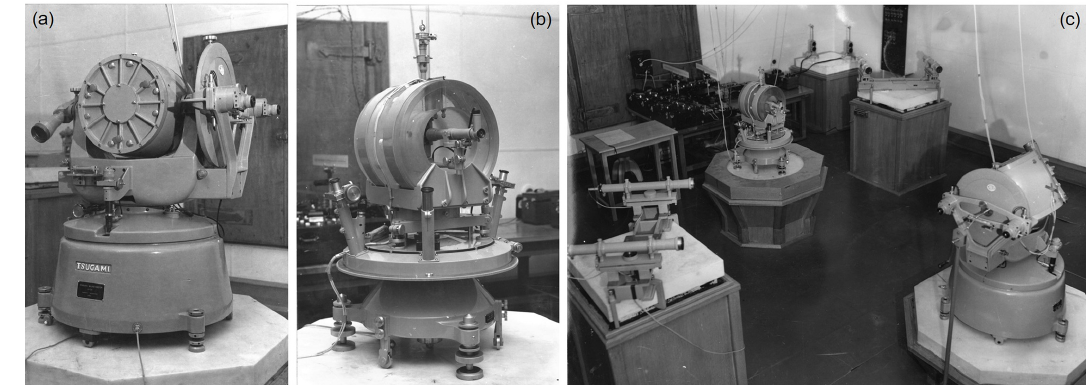
Figure 18. New theodolites developed by Kakioka Magnetic Observatory. (a) A-56 for the horizontal force, the vertical component, the declination and the inclination, (b) H-56 for the horizontal force, and (c) the absolute measurement room with A-56, H-56, and attached equipment such as collimators and a voltmeter (photo supplied by Kakioka Magnetic Observatory).